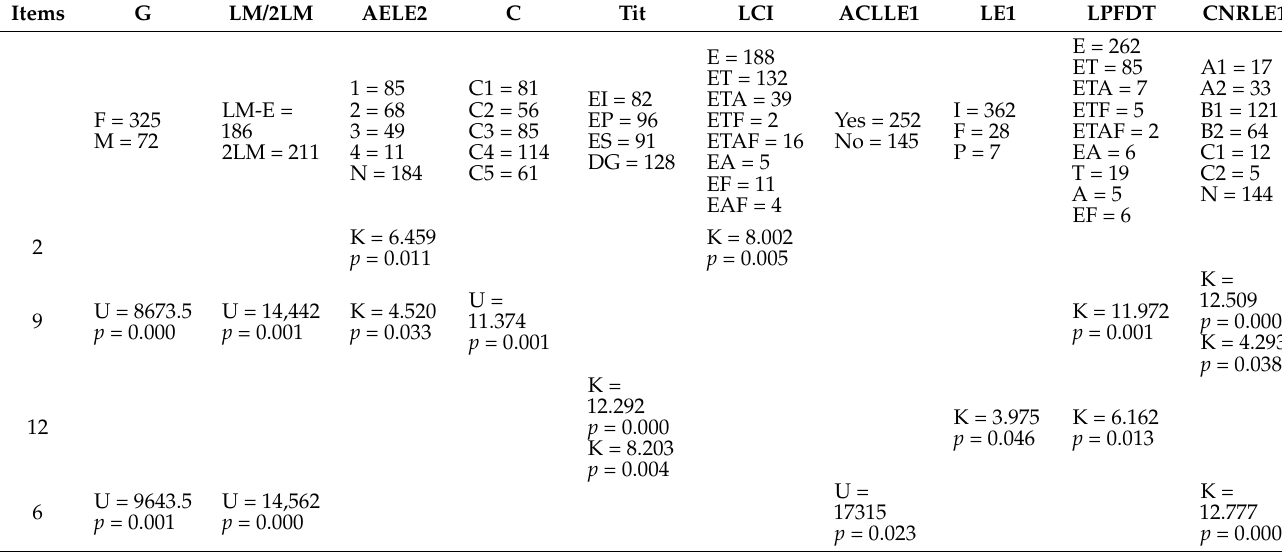
Table 4. Comparative statistics on the beliefs on the multiple intelligences and learning